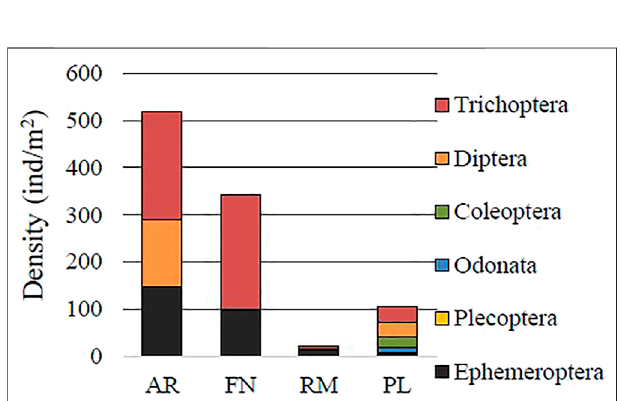
FIGURE3| DensityofInsectagroupsofsamplingriver(AR:Arroyito,FN: Fortín Nogueira) and reservoir (RM, Ezequiel Ramos Mexía; PL, Pichi Picún Leufú) sites of Limay River,